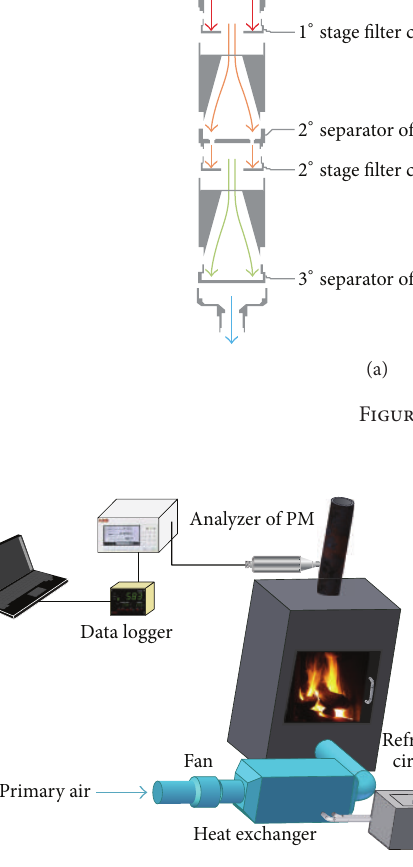
Figure 2: Scheme of experimental setup.